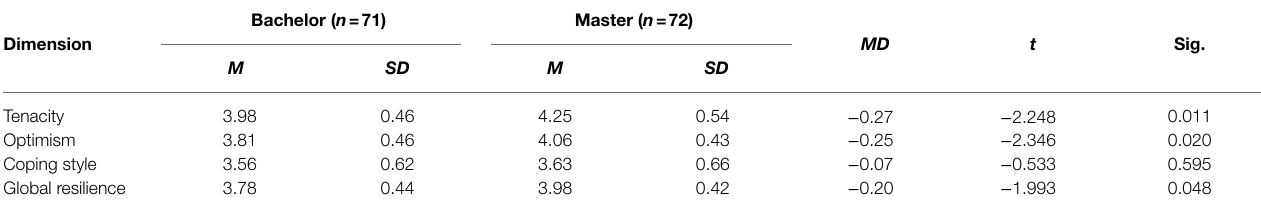
TABLE 6 | The independent-samples t -test of EFL teacher resilience on educational background.